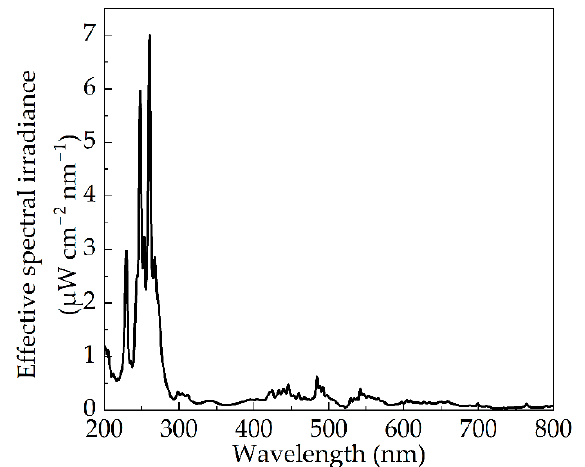
Figure 11. Effective spectral distribution of pulsed xenon lamp weighted by spectral inactivation curve in Figure 10.